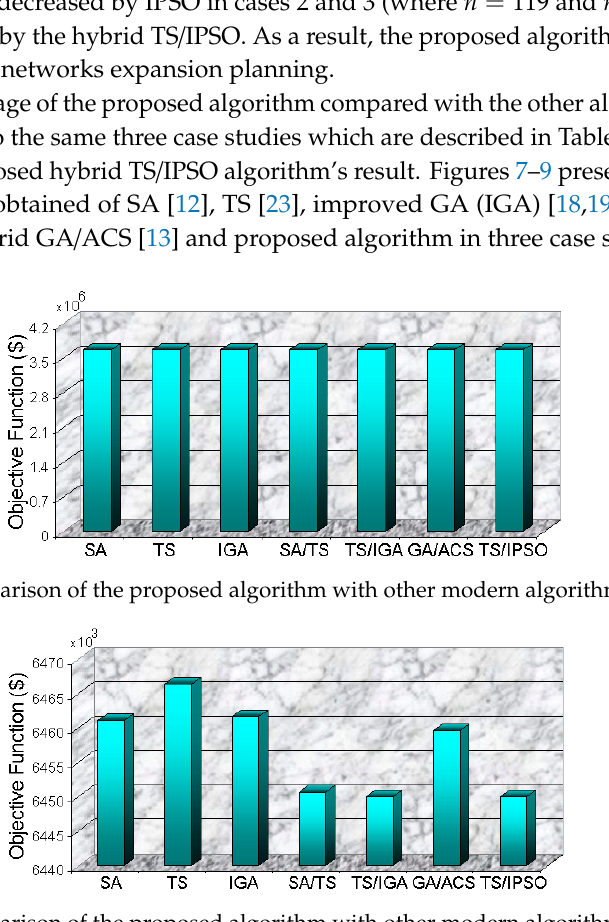
Figure 8. Comparison of the proposed algorithm with other modern algorithms in case 2.